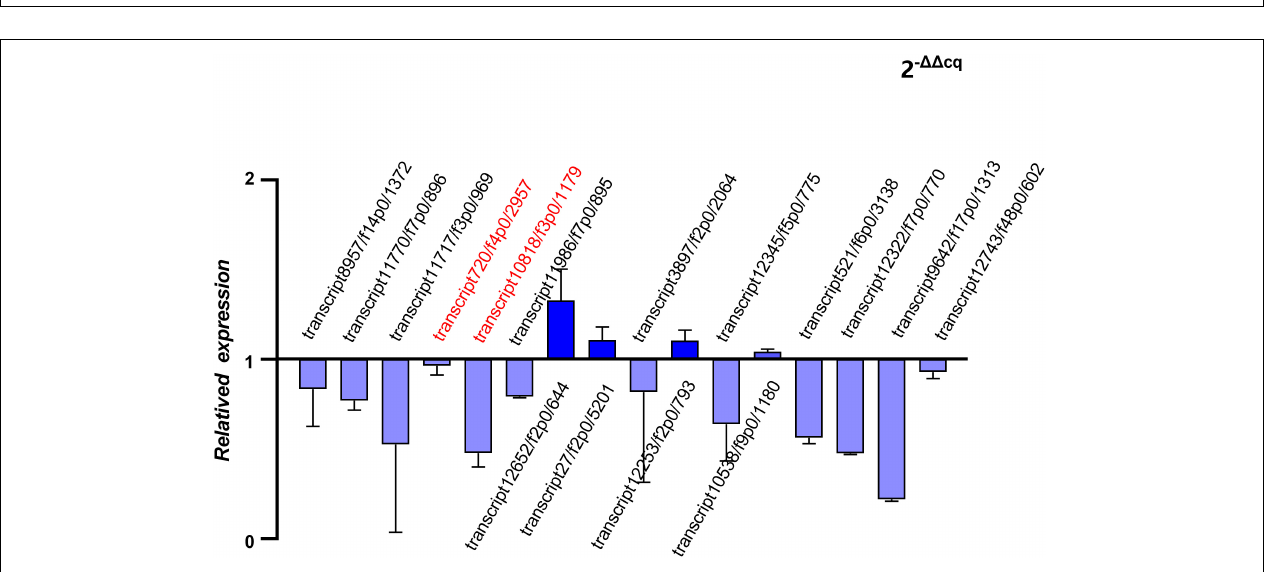
FIGURE 7 | Quantitative real-time reverse transcription PCR (qRT-PCR) of hub genes and putative allergen genes (relative expression of Ocy_N_L groups to Ocy_A groups).